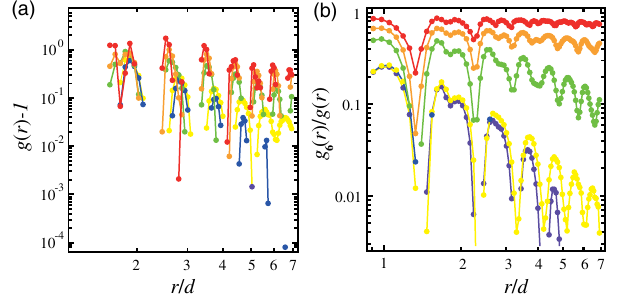
FIG. 7. ϕ dependence of g ð r Þ and g 6 ð r Þ =g ð r Þ for a rubber ball system at Γ ¼ 3 . 3 . (a) ϕ dependence of g ð r Þ . The symbols are ϕ ¼ 0 . 65 (blue), 0.69 (yellow), 0.70 (green), 0.74 (orange), and 0.80 (red) from the bottom to the top. (b) ϕ dependence of g 6 ð r Þ =g ð r Þ . The symbols are ϕ ¼ 0 . 65 (bule), 0.69 (yellow), 0.70 (green), 0.74 (orange), and 0.80 (red) from the bottom to the top.